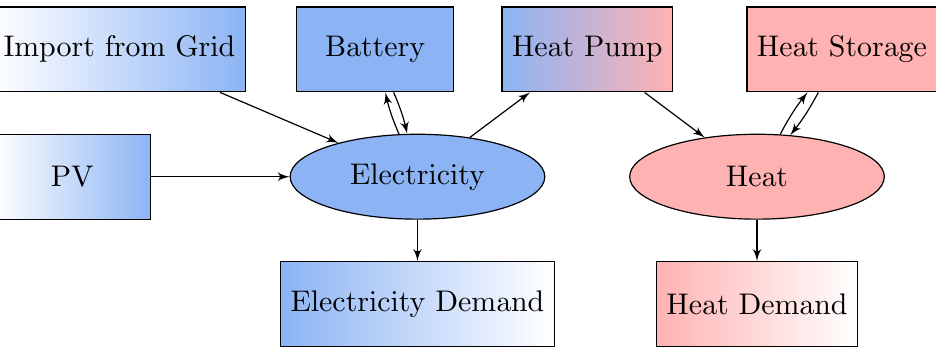
Figure 1. Schematic overview of exemplary energy system model of a building with photovoltaic (PV) power plant. Energy commodities are displayed as ellipses and energy conversion processes as rectangles. Arrows of a conversion process denote which energy commodities can be transformed into each other, while colors encode different types of energy. Conversion processes without input or output represent energy demands or energy imports into the model